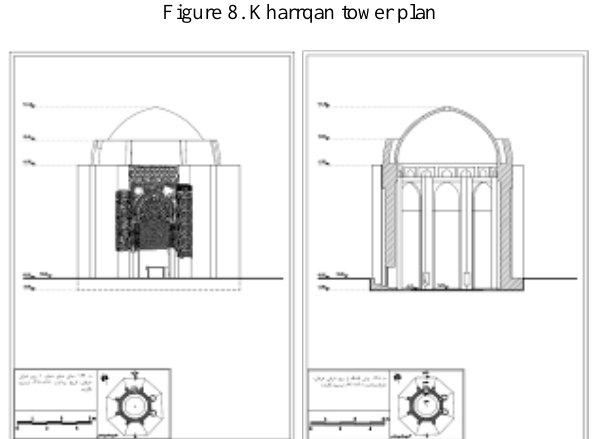
Figure 8. Kharrqan tower plan